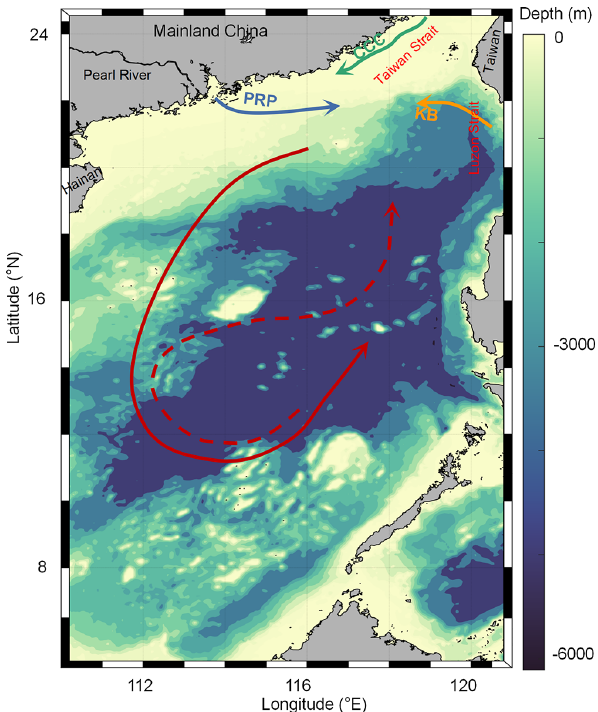
Figure 1. Topographic map of the South China Sea (SCS) showing the basin-wide cyclonic circulation in winter (solid line) and anti- cyclonic circulation over the southern half of the SCS in summer (dashed line). Also shown are the Kuroshio branch (KB; orange line), the China coastal current (CCC; green line), and the Pearl River plume (PRP; blue